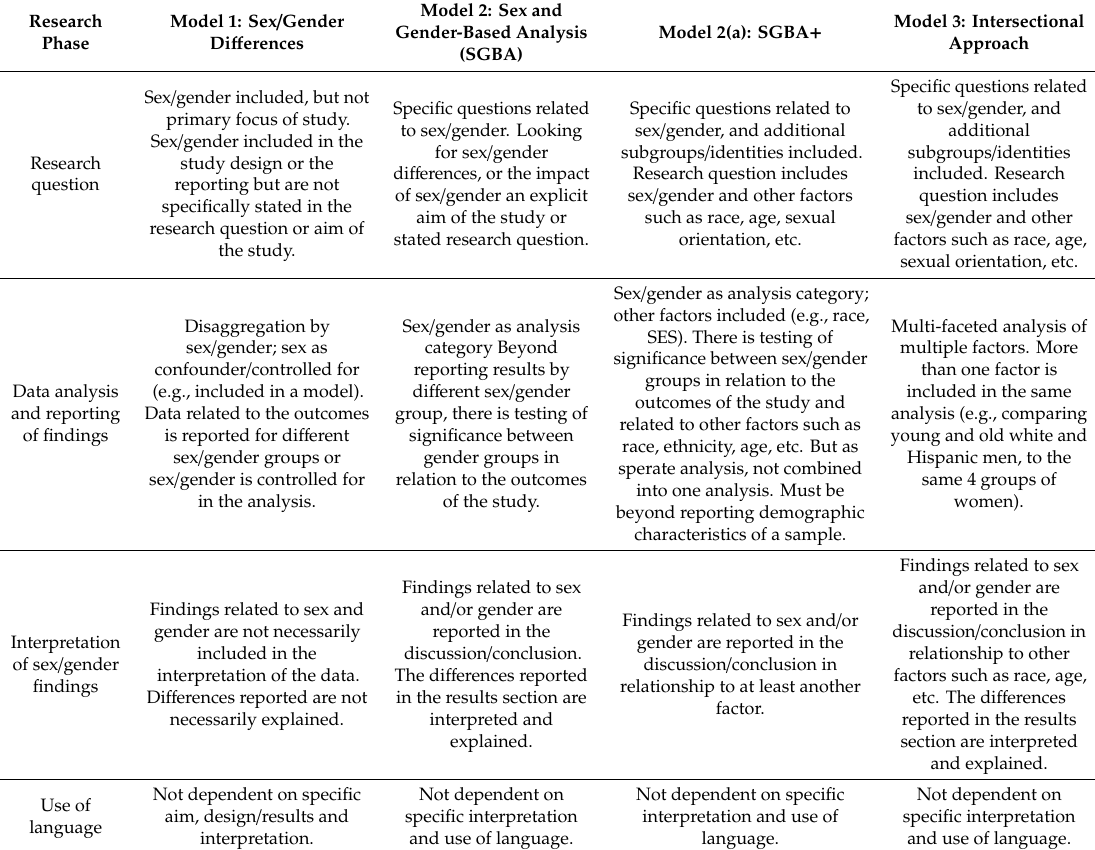
Table 1. Sex- and gender-based analysis in health